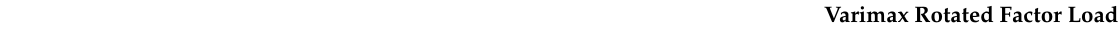
Table 3. Summary of results from the exploratory factor analysis of the BIOTICA questionnaire ( n = 68), with 15-items, translated from German. Item numbering refers to the order of the item in the questionnaire (Supplementary File, Supplement